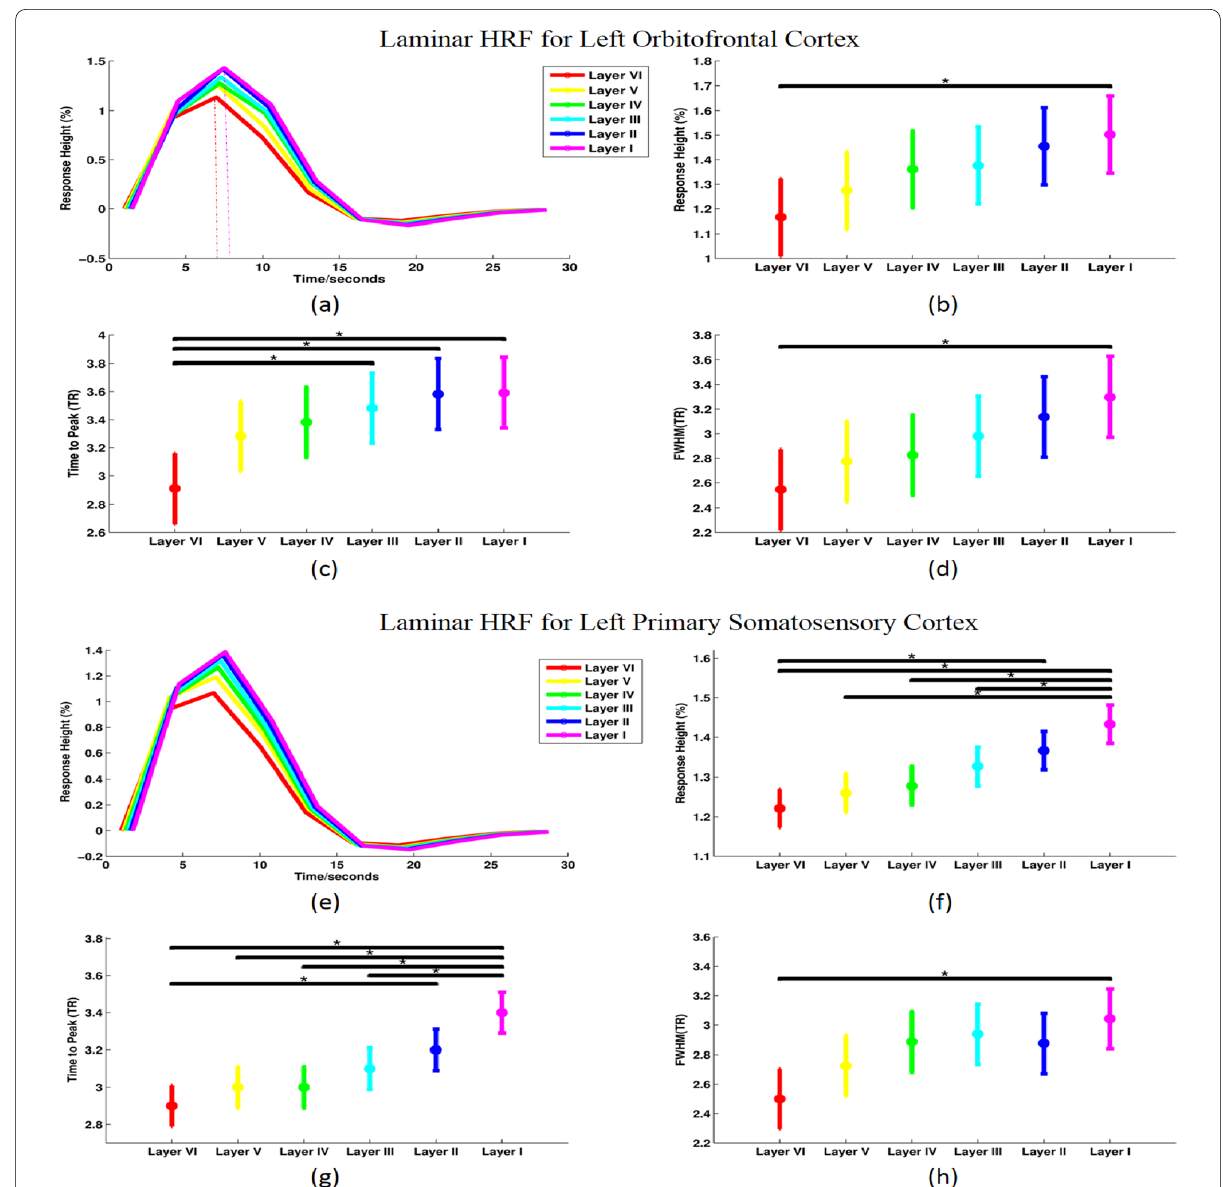
Fig. 5 Region-specific HRF plot and multiple comparisons across the layers for left orbitofrontal cortex (OFC) ( a – d ) and left primary somatosensory cortex (S1) ( e , f ). The mean left OFC ( a ) and left S1 ( e ) HRF plot for six layers separately. Layer VI (red), layer V (yellow), layer IV (green), layer III (cyan), layer II (blue), and layer I (purple); multiple comparisons across the layers for left OFC ( b ) and left S1 ( f ) for response height; time to peak multiple comparisons across layers for left OFC ( c ) and left S1 ( g ); FWHM multiple comparisons across the layers for left OFC ( d ) and left S1 ( h ). *Significant difference with p (corrected) < 0.05. The error bar indicates the estimated standard